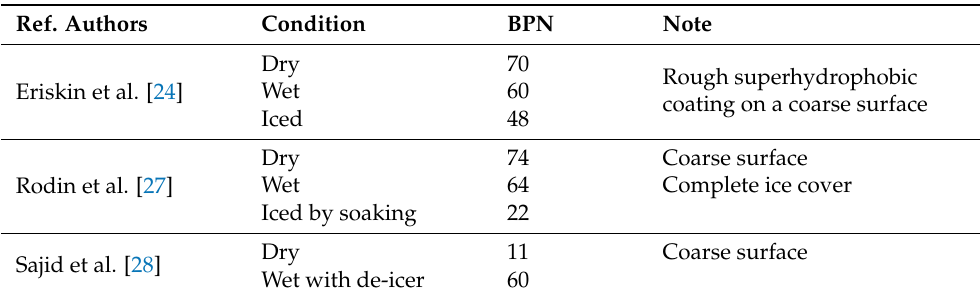
Table 1. Main Results obtained using BPT with winter conditions. Ref.